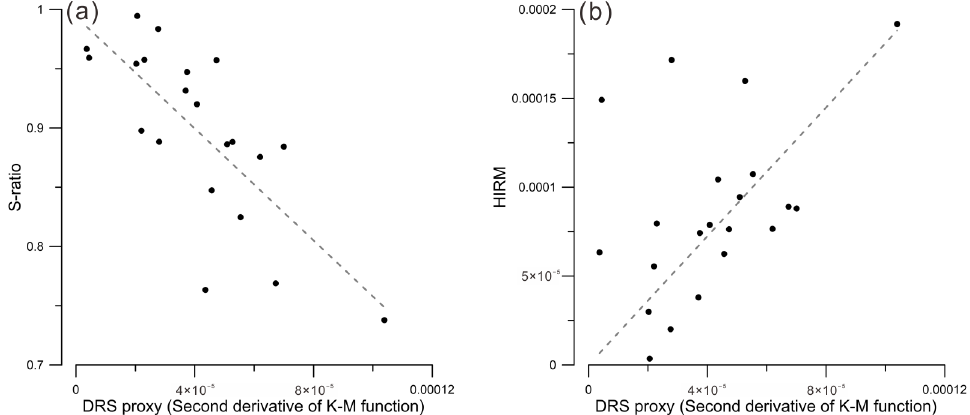
Figure 9. Comparison between DRS and magnetic methods in detecting natural samples. ( a ) S-ratio versus DRS and ( b ) HIRM versus DRS.